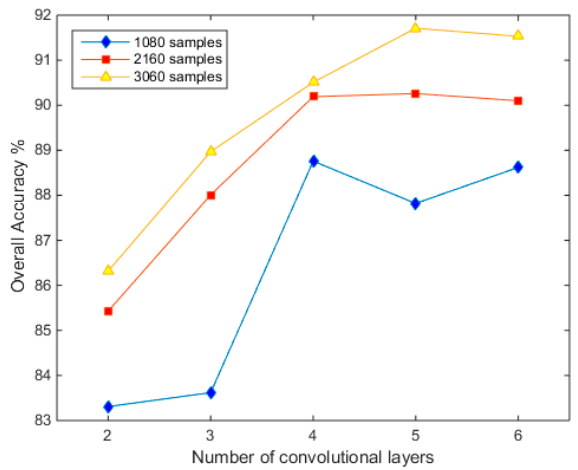
Figure 6. Effect of varying number of convolutional layers while varying the training sample size.